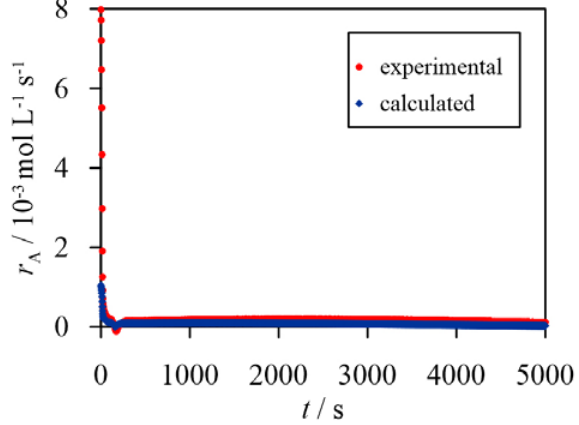
Figure 4. Experimental and calculated reaction rates, - r , as a func- L function of time, at the temperature, ϑ = 30 °C and mole fraction of ethanol, x = EtOH